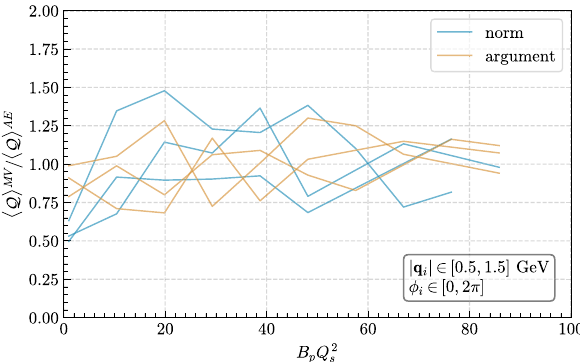
Fig. 10 Ratio of the Fourier transform of Eqs. (A11) and (A10) at different values of B p . The values of the ratio were computed using three sets of random momenta with moduli between 0.5 and 1.5 GeV. We present both the norm (blue lines) and the argument (yellow lines). We have suppressed the values where the estimated error in the Monte Carlo integration becomes larger than 10% tends to the MV model but integrals become very time consuming which prevents reaching larger values of B p Q 2